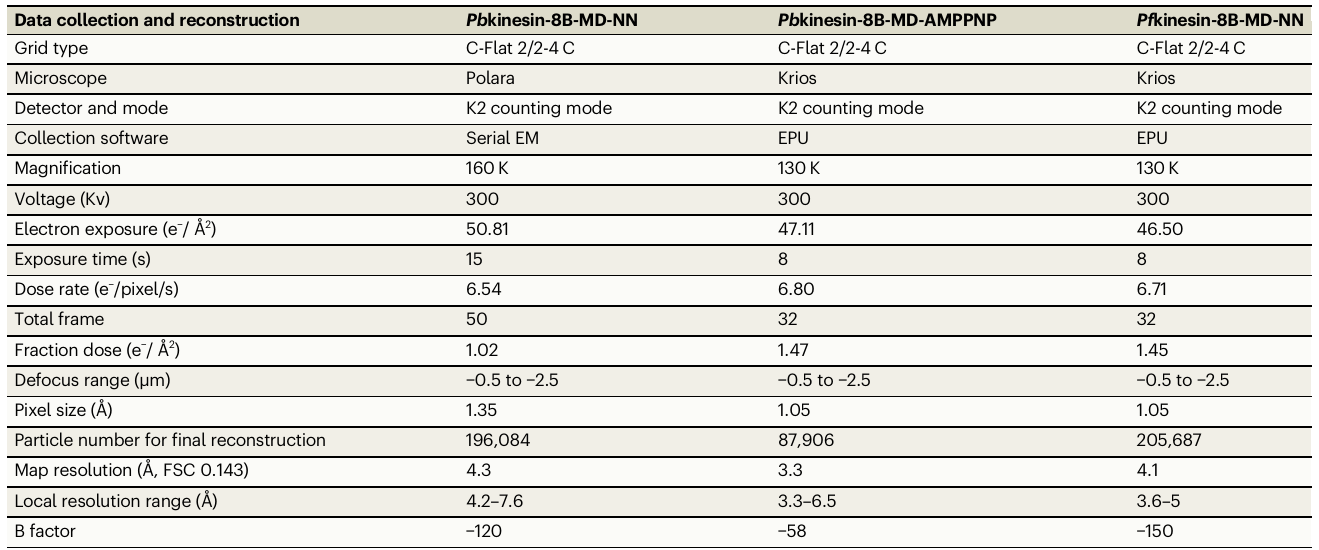
Fig. 3 | Cryo-EM reconstructions of MT-bound Pb kinesin-8B-MD. a Asymmetric unit of GMPCPP-MT-bound NN Pb kinesin-8B-MD as solid surface towards NBS (threshold=0.0322). Pb kinesin-8B-MD-NN is dark green, α / β -tubulin dark/light grey, respectively; region around NBS depicted in b is boxed. b Zoom-in of NN Pb kinesin-8B-MD NBS with docked model, showing contact formed between the helical turn (arrow) in loop 11 (yellow) and α -tubulin, P-loop (orange) in the empty NBS, and density corresponding to fl exible-appearing loop 9 (blue). Pb kinesin-8B- MD-NN model is dark green, α / β -tubulin dark/light grey, respectively. c MT-bound NN Pb kinesin-8B-MD as solid surface towards the neck linker region (threshold= 0.0322). Pb kinesin-8B-MD-NN is dark green, α / β -tubulin are dark/light grey respectively;regionaroundthenecklinkerdepictedin d isboxed. d Zoom-inofNN Pb kinesin-8B-MD neck linker region with docked model, showing density corre- sponding to loop 12 (fuchsia) at C-terminus of helix- α 4 that contacts β -tubulin, adjacent to which is density corresponding to the N-terminal end of the neck linker (red), which is directed towards the MT minus end. e Asymmetric unit of GMPCPP-MT-bound AMPPNP Pb kinesin-8B-MD as solid surface towards NBS